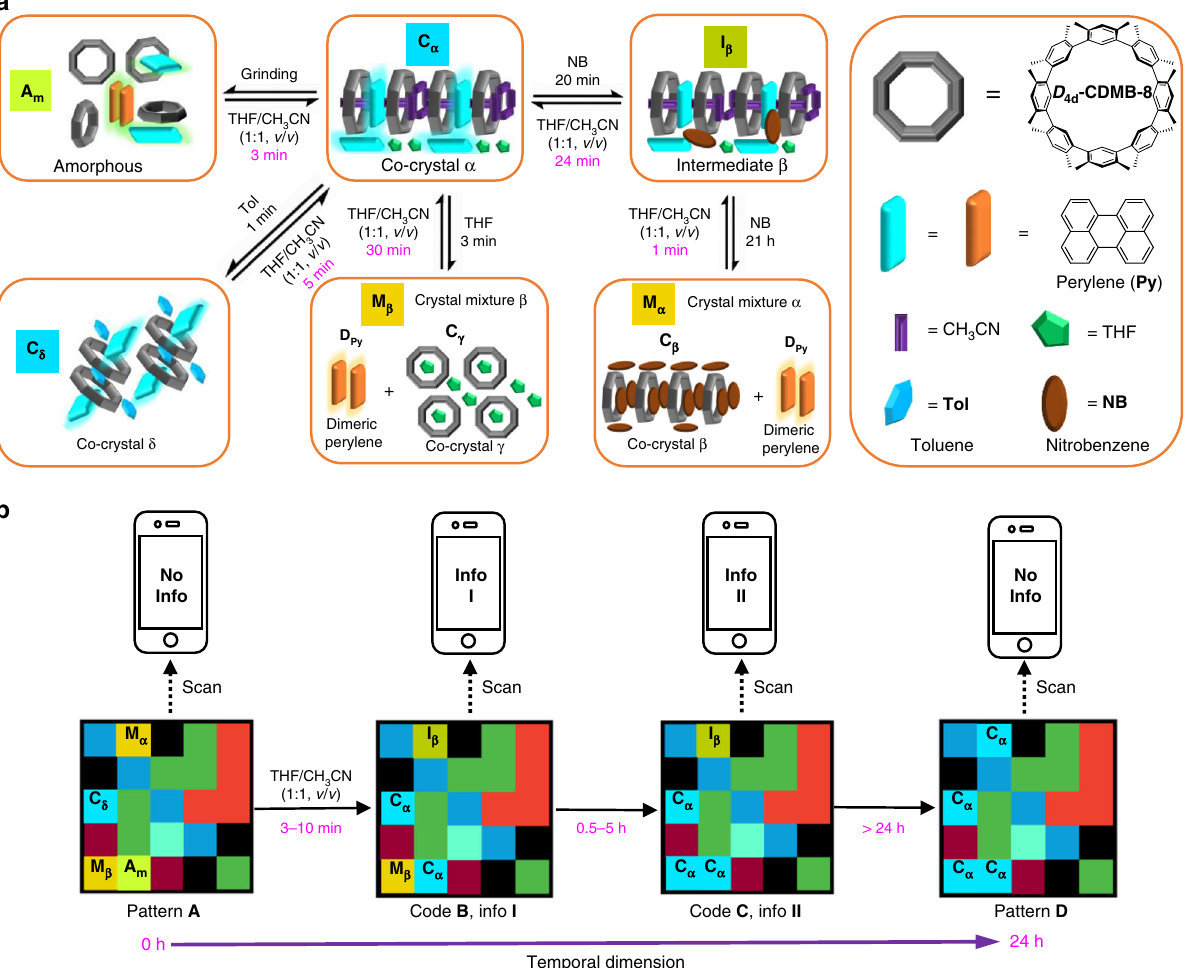
Fig. 1 Schematic representations of solvent promoted solid-state molecular motion involving host-guest complexes and the 4D information coding the accompanying changes permit. a An organic solvent, applied to the solid forms as either a liquid or vapour, promotes solid-state molecular motion and leads to transformation between co-crystalline phases, as well as production of mixed crystalline states and an amorphous form. Also shown by use of highlighting (light blue vs orange) is the time resolved colour response produced under both room light and UV illumination (365 nm). See text for further details. b 4D information coding via a solvent-induced time-dependent vapoluminescent